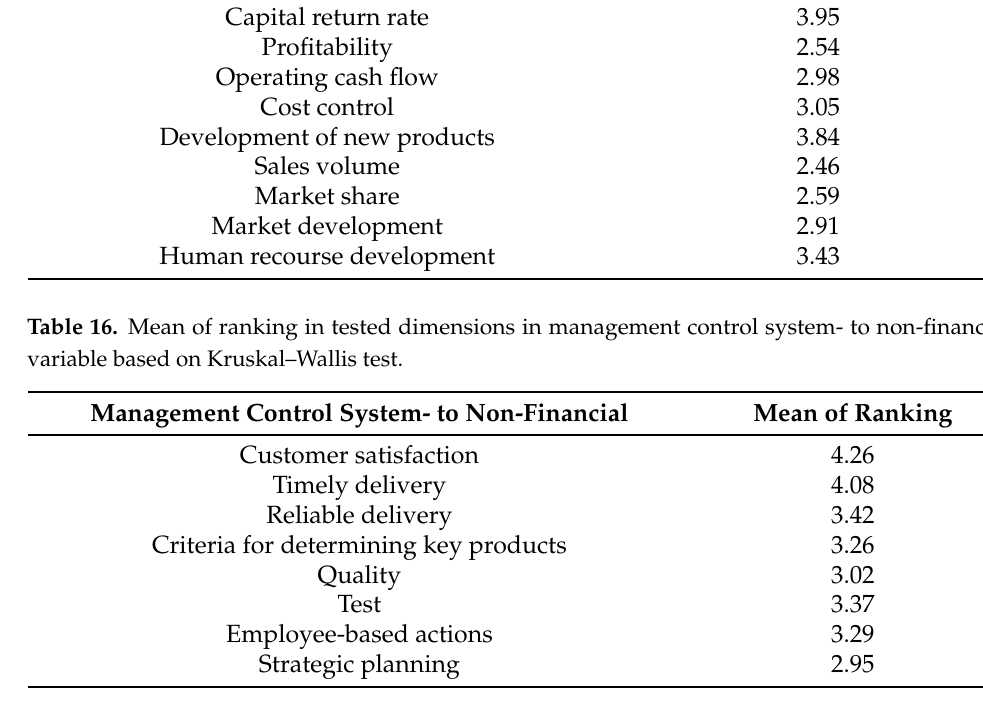
Table 17. Mean of ranking in tested dimensions in management control system- to financial variable based on Kruskal–Wallis